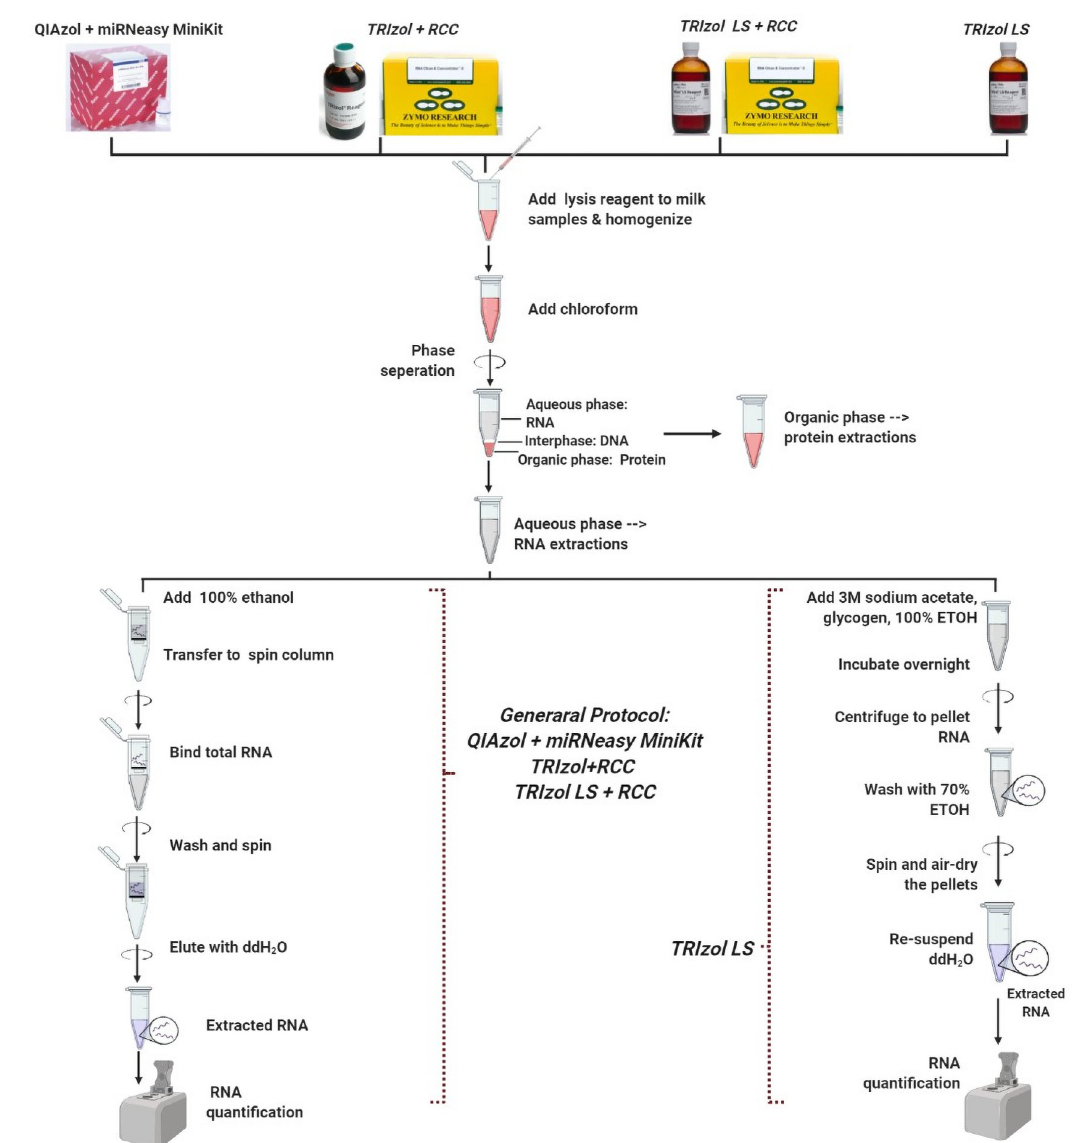
Fig 3. Four RNA extraction protocols. 1) QIAzol + miRNeasy MiniKit (Q), 2) TRIzol LS (TLS), 3) TRIzol + RNA Clean and Concentrator Kit (Tri+RCC), and 4) TRIzol LS + RNA Clean and Concentrator Kit (TLS+RCC) used for the isolation of total RNA from bovine and human milk